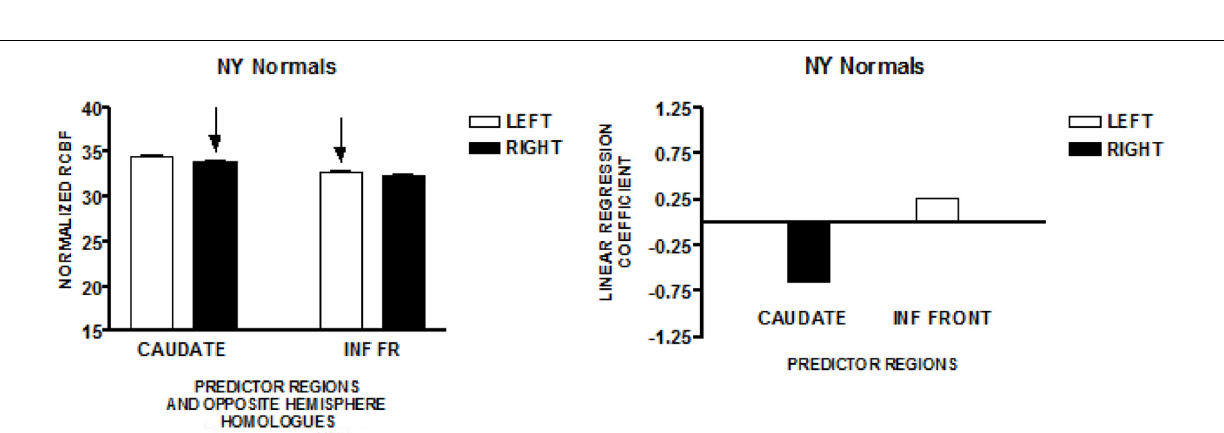
FIGURE 2 | The results from a similar study of speech production in a group of normal volunteers in New York (NY). The graph on the left presents the mean normalized CBF ( ± SEM) for the head of the caudate nuclei, and the inferior frontal region, bilaterally. The graph on the right presents the linear regression weights for the two predictor regions (Sidtis et al., 2018).